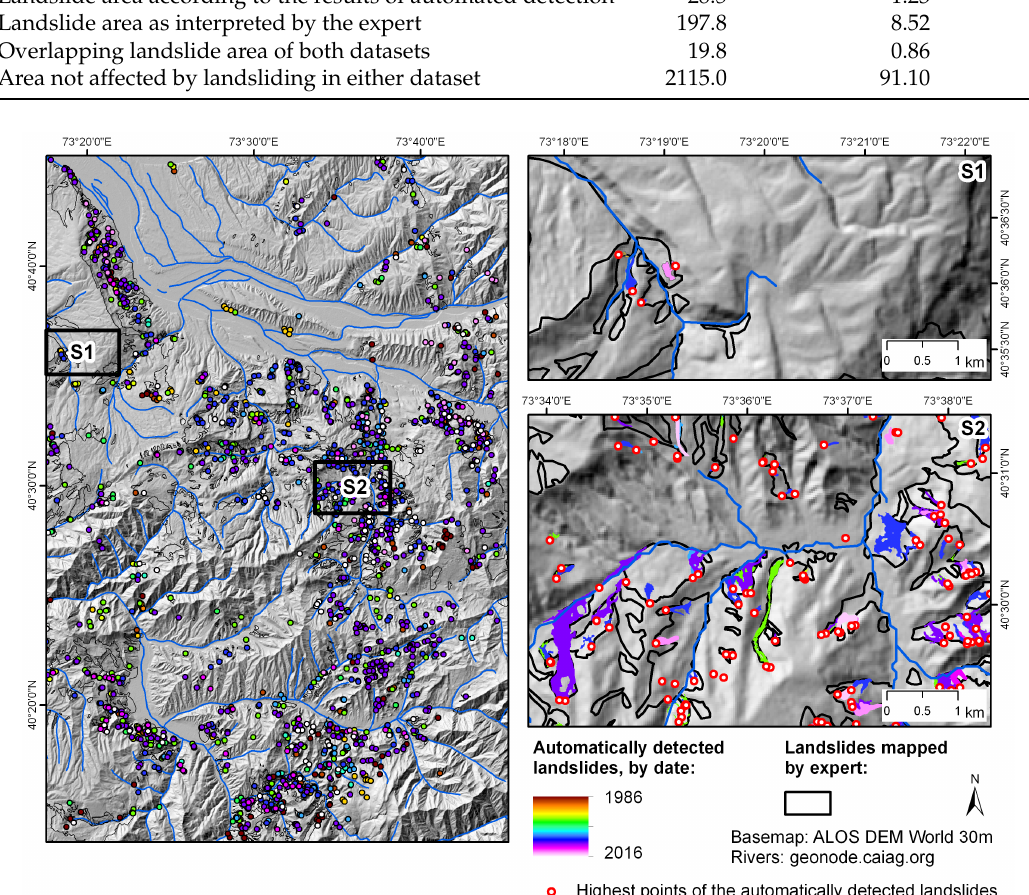
Figure 2. Landslides in the study area mapped by expert interpretation (black contours) and automated detection (colored polygons and points). The points in the overview map are the centroids of the automatically detected landslide polygons. The representation with points is for visualization purposes only; the actual dataset contains